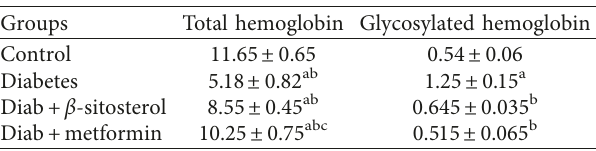
Table 4: Outcome of β -sitosterol on plasma Hb and HbA1c of control and diet-fed diabetic male